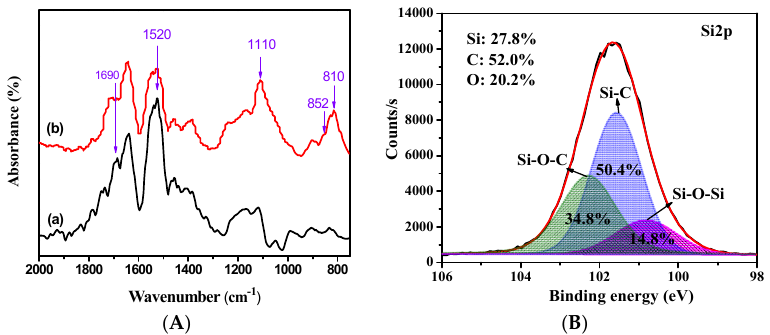
Figure 6. ( A ) FTIR spectra of the bifacial fabric: (a) untreated and (b) plasma treated; ( B ) XPS Si2p spectra of HMDSO plasma polymer.